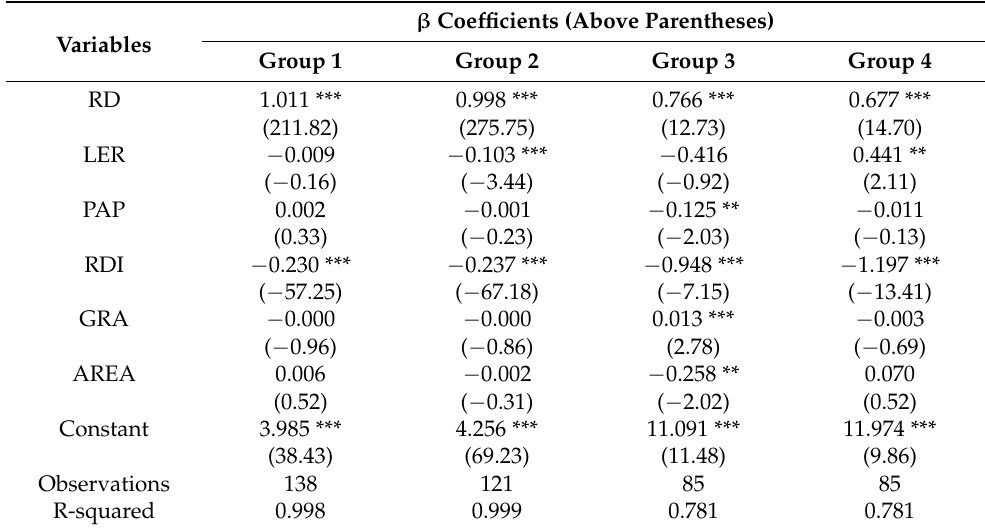
Table 4. Regression results of sub-groups for different regulations (Model